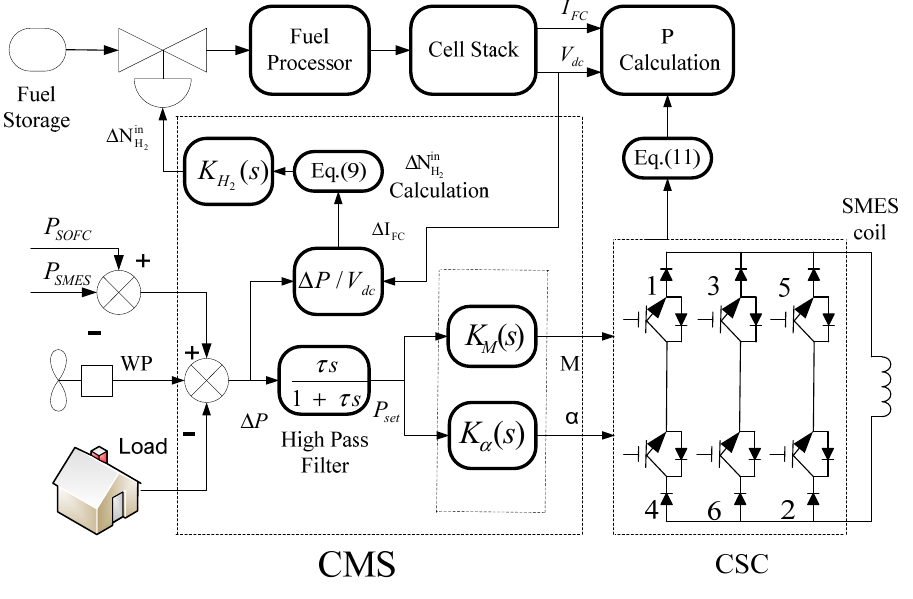
Figure 8. Block diagram of the proposed control scheme.